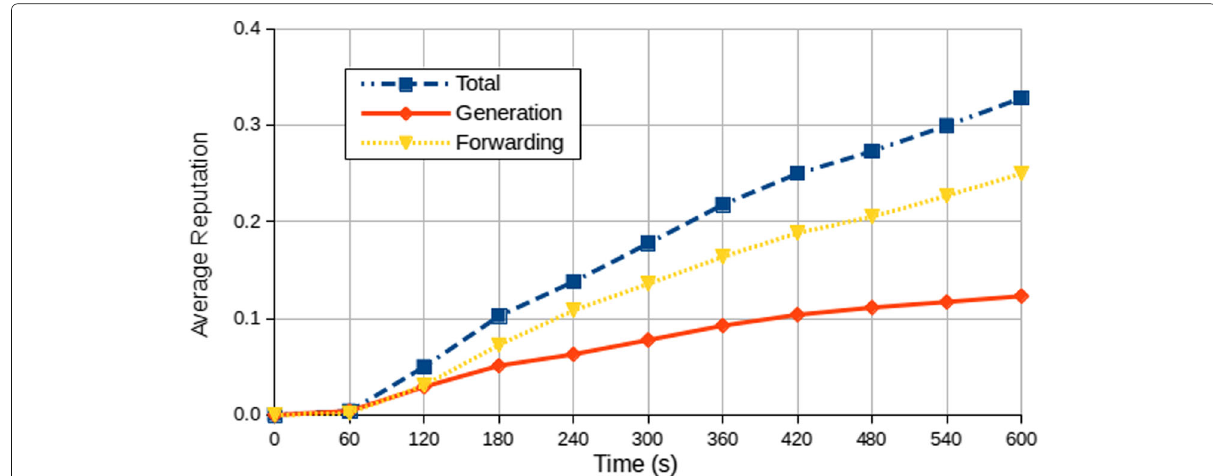
Fig. 8 Results of AR with MV =